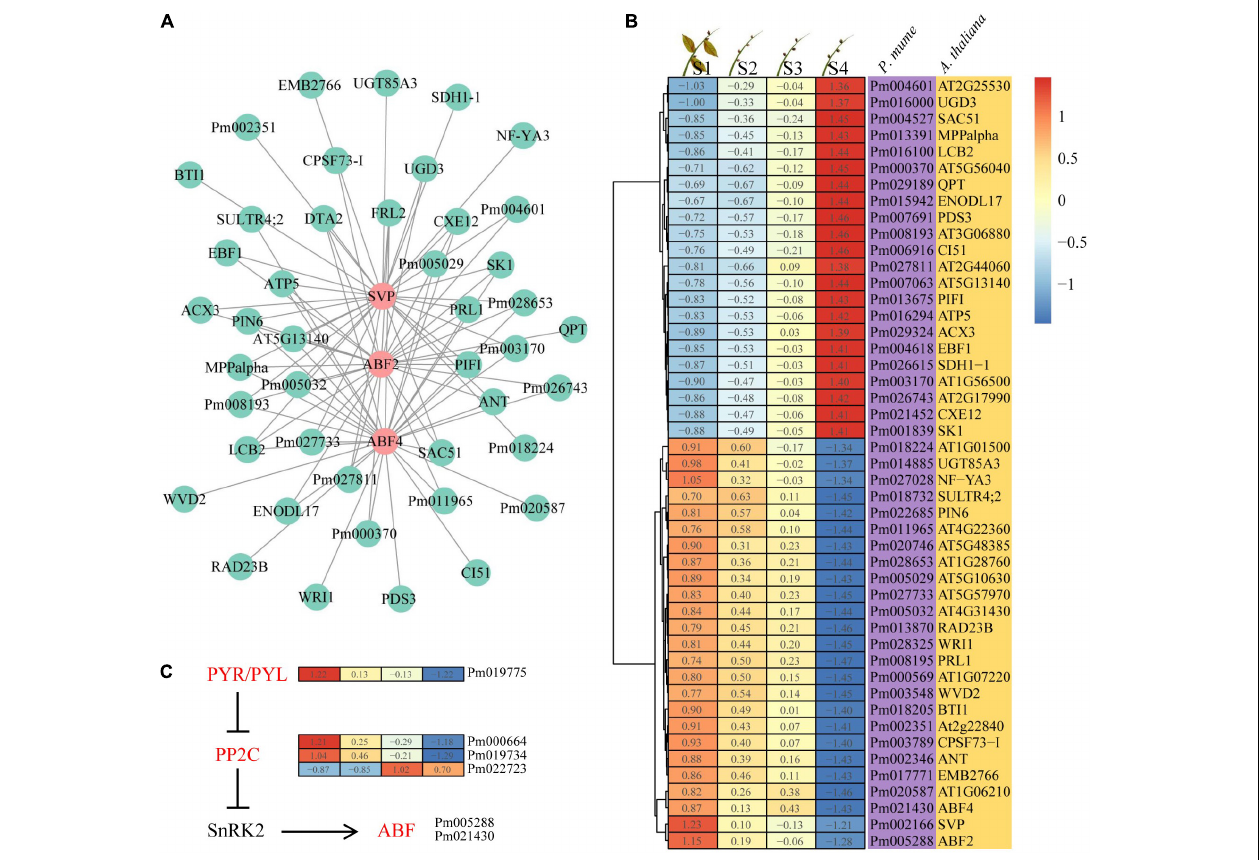
FIGURE 5 | Interaction network and expression of the hub genes. (A) Interaction of gene co-expression network of the hub genes. (B) Heat map showing the genes that were expressed at four different dormancy stages of Prunus mume . (C) Abscisic acid (ABA) signal transduction pathway. The ABA-related genes in yellow module were highlighted in red.